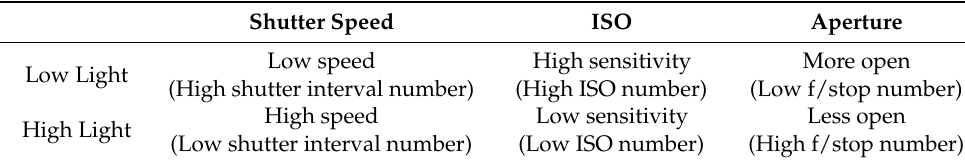
Table 4. Ambient Light vs. Camera